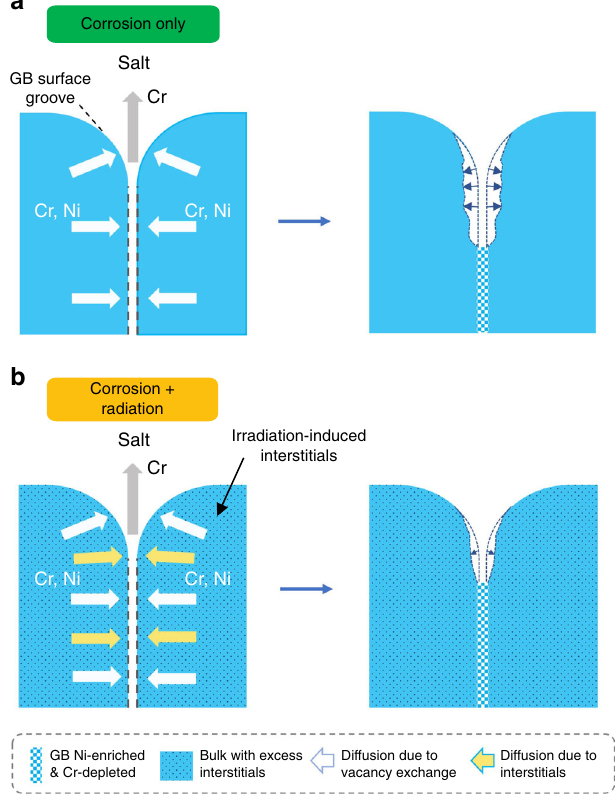
Fig. 4 Proposed mechanism of radiation-decelerated corrosion. a Schematic of the solid-state diffusion processes during molten salt corrosion in Ni-20Cr. b Schematic of the solid-state diffusion processes during molten salt corrosion in Ni-20Cr under the in fl uence of proton